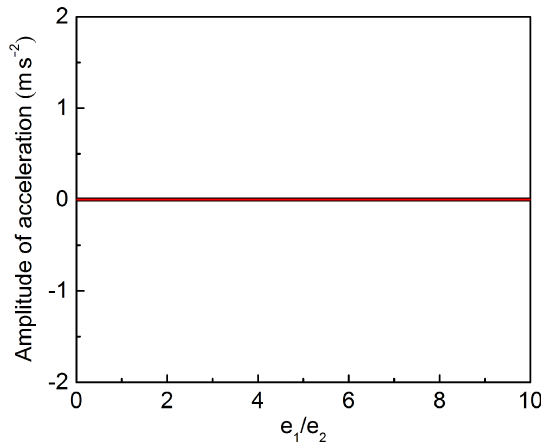
Figure 6. Effects of e 1 /e 2 on the amplitude when ω 1 = ω 2 ( e 1 + e 2 = 2 e ).